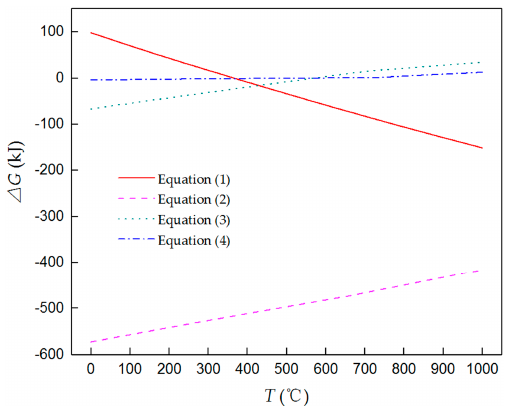
Figure 4. The traditional powder thermal di ff usion alloying process on magnesium alloys in a vacuum 4 or inert atmosphere ( a ) and in the air ( b ).